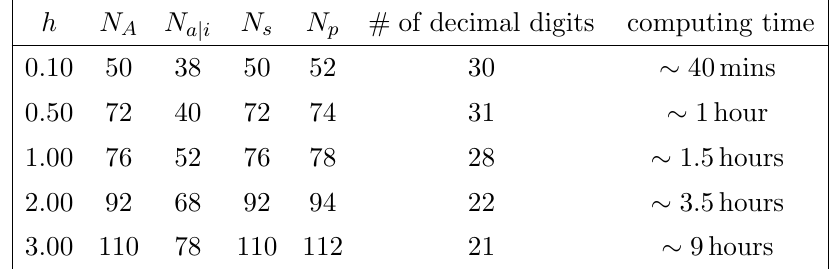
Table 1 . Set of parameters used to get some of the conformal dimensions of the sl (2)-like operator with L = 1, S =